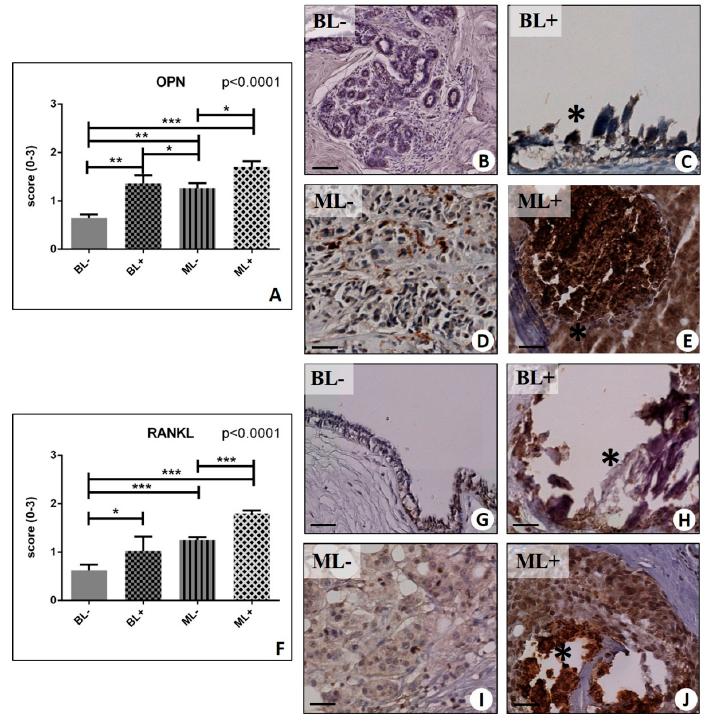
Figure 2. Immunohistochemical evaluation of osteopontin (OPN) and nuclear factor kappa-B ligand (RANKL). ( A ) Graph shows the expression of OPN in BL − , BL+, ML − , and ML+ groups. ( B ) Breast fibroadenoma with no/rare OPN-positive cells. ( C ) Breast microcalcifications (asterisk) surrounded by OPN-positive cells in a fibroadenoma. ( D ) Several OPN-positive cells in breast infiltrating carcinoma. ( E ) Very high expression of OPN in cells close to microcalcification (asterisk) in an in situ ductal carcinoma. ( F ) Graph shows the expression of RANKL in BL − , BL+, ML − , and ML+ groups. ( G ) Rare RANKL-positive cells in breast fibroadenoma. ( H ) Image shows numerous RANKL-positive breast cell next to calcification (asterisk) in a fibroadenoma. ( I ) Faint staining for RANKL in breast infiltrating carcinoma. ( J ) Several RANKL-positive breast cancer cells next to microcalcifications (asterisk) in infiltrating carcinoma. (* p < 0.05; ** p < 0.01; *** p < 0.001). Scale bar represents 100 µm in all images.